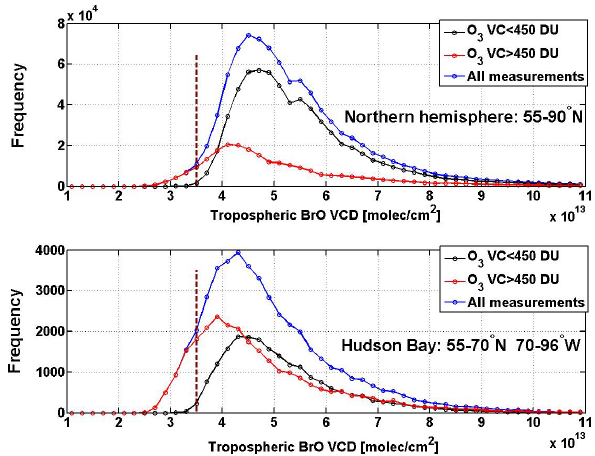
Fig. 11. Histograms of GOME-2 tropospheric BrO vertical columns for the satellite “BrO hostpots” observations (regions where BrO total columns are elevated by at least 2 × 10 13 moleccm − 2 rela- tive to the zonal mean). The data from February to May (2007 and 2008) are considered for (upper plot) the Northern Hemisphere (55–90 ◦ N) and (lower plot) the Hudson Bay (55–70 ◦ N, 70–96 ◦ W). Black and red lines show the frequency distributions of data with O 3 vertical columns lower and higher than 450 Dobson Units, respec- tively. Blue lines: no distinction is made. The brown vertical dashed line corresponds to the upper limit of the residual tropospheric BrO vertical columns for the events of possible of stratospheric origin (see